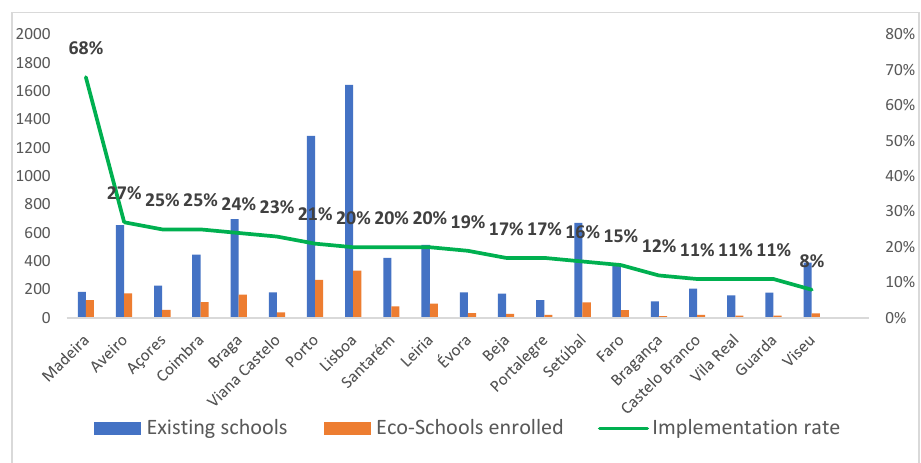
Figure 2. District implementation rate: schools enrolled vs. total schools. Source: (ABAE 2021, 2022a).